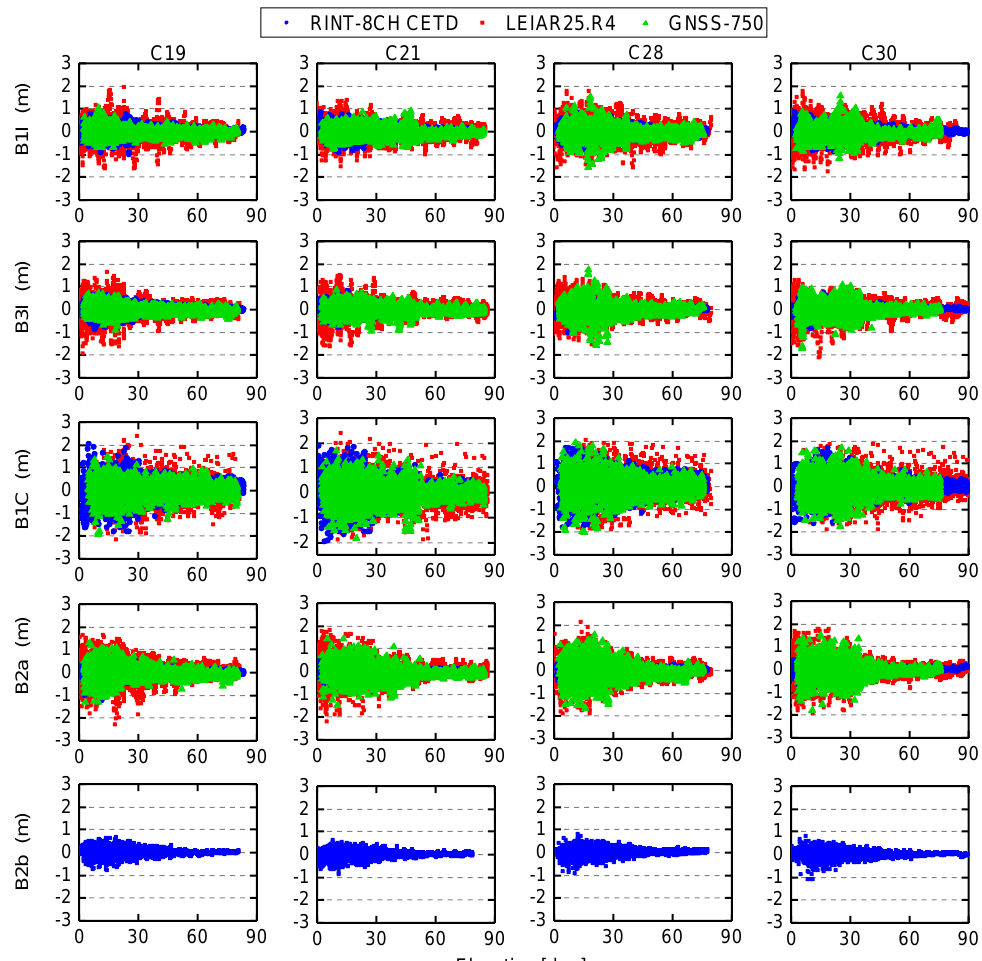
Figure 7. MP combinations as a function of elevation for four BDS-3 satellites on five frequencies of signals observed at three iGMAS stations equipped with different antennas (RINT-8CH CETD/LEIAR25.R4 LEIT/GNSS-750) during DOY 150-152, 2018. The five rows from top to bottom represent five BDS-3 signals: B1I, B3I, B1C, B2a, and B2b; the four columns from left to right represent four selected BDS-3 satellites: C19, C21, C28, and C30. Table 4. Triple-frequency carrier phase combinations for analysis of carrier phase noise and multipath errors, as well as the inter-frequency clock bias (IFCB) variations.